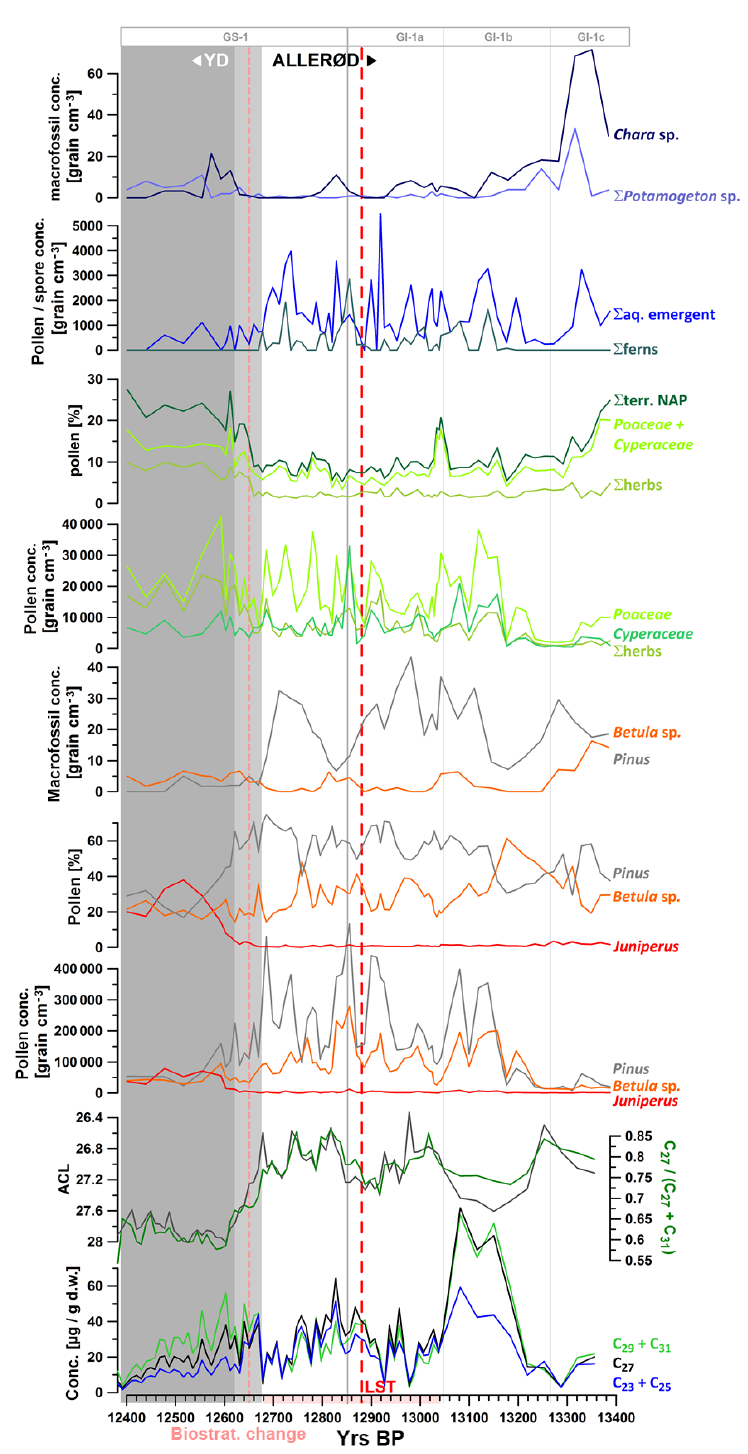
Figure 4. High-resolution palynological data from the Allerød and transition into the YD in comparison to concentration of n -alkanes, ACL, and the C 27 /(C 27 + C 31 ) n -alkane ratio. The light grey shaded period indicates the transition from the Allerød to the YD (12680– 12620yrBP) as defined by Słowinski et al. (2017), while the dark grey shaded interval marks the YD. NGRIP ice core stratification according to Rasmussen et al. (2014). (cid:54) herbs: NAP without Poaceae and